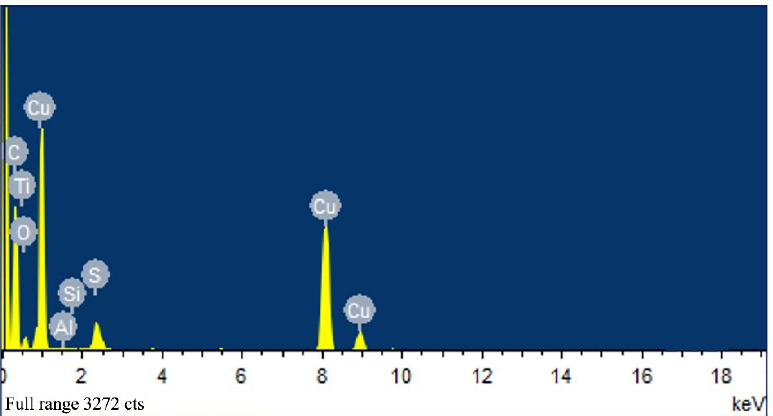
Figure 11. EDS spectrum of the sample stored in absolute ethanol .